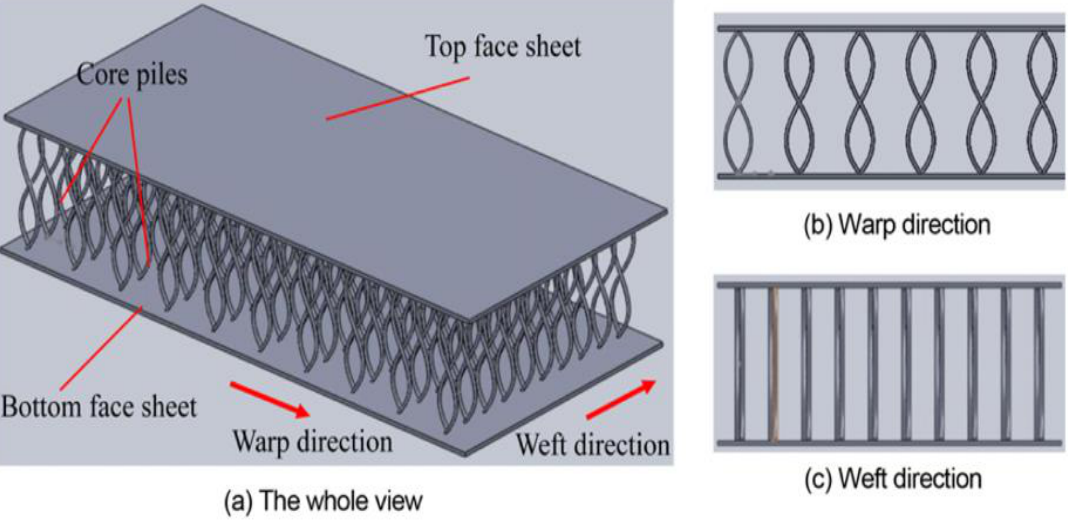
Figure 14. 3D-integrated woven spacer composite structure diagram ( a ) the whole view, ( b ) warp direction ( c ) weft direction [183] (reprinted with permission from Springer Nature, Licence Num- ber:5447071147988).